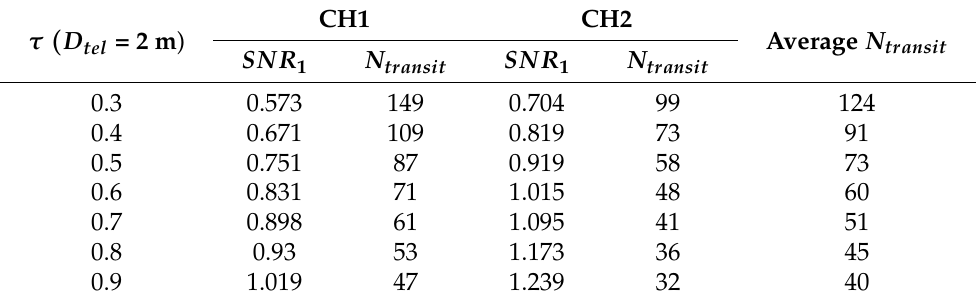
Table 2. SNR 1 and N transit values varying with throughput when D tel = 2 m for GJ 1214 b. τ ( D tel = 2 m